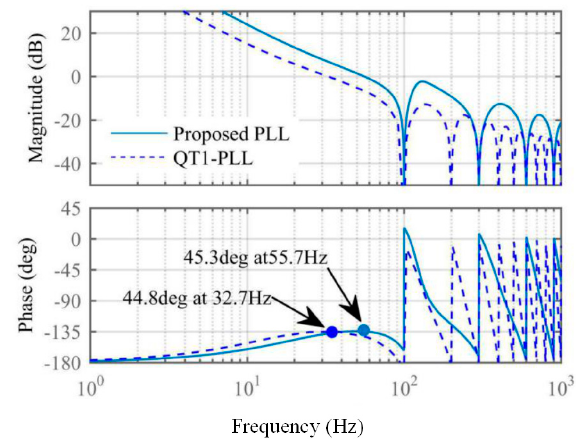
Figure 14. Bode plot of open-loop transfer function in proposed PLL and QT1-PLL.